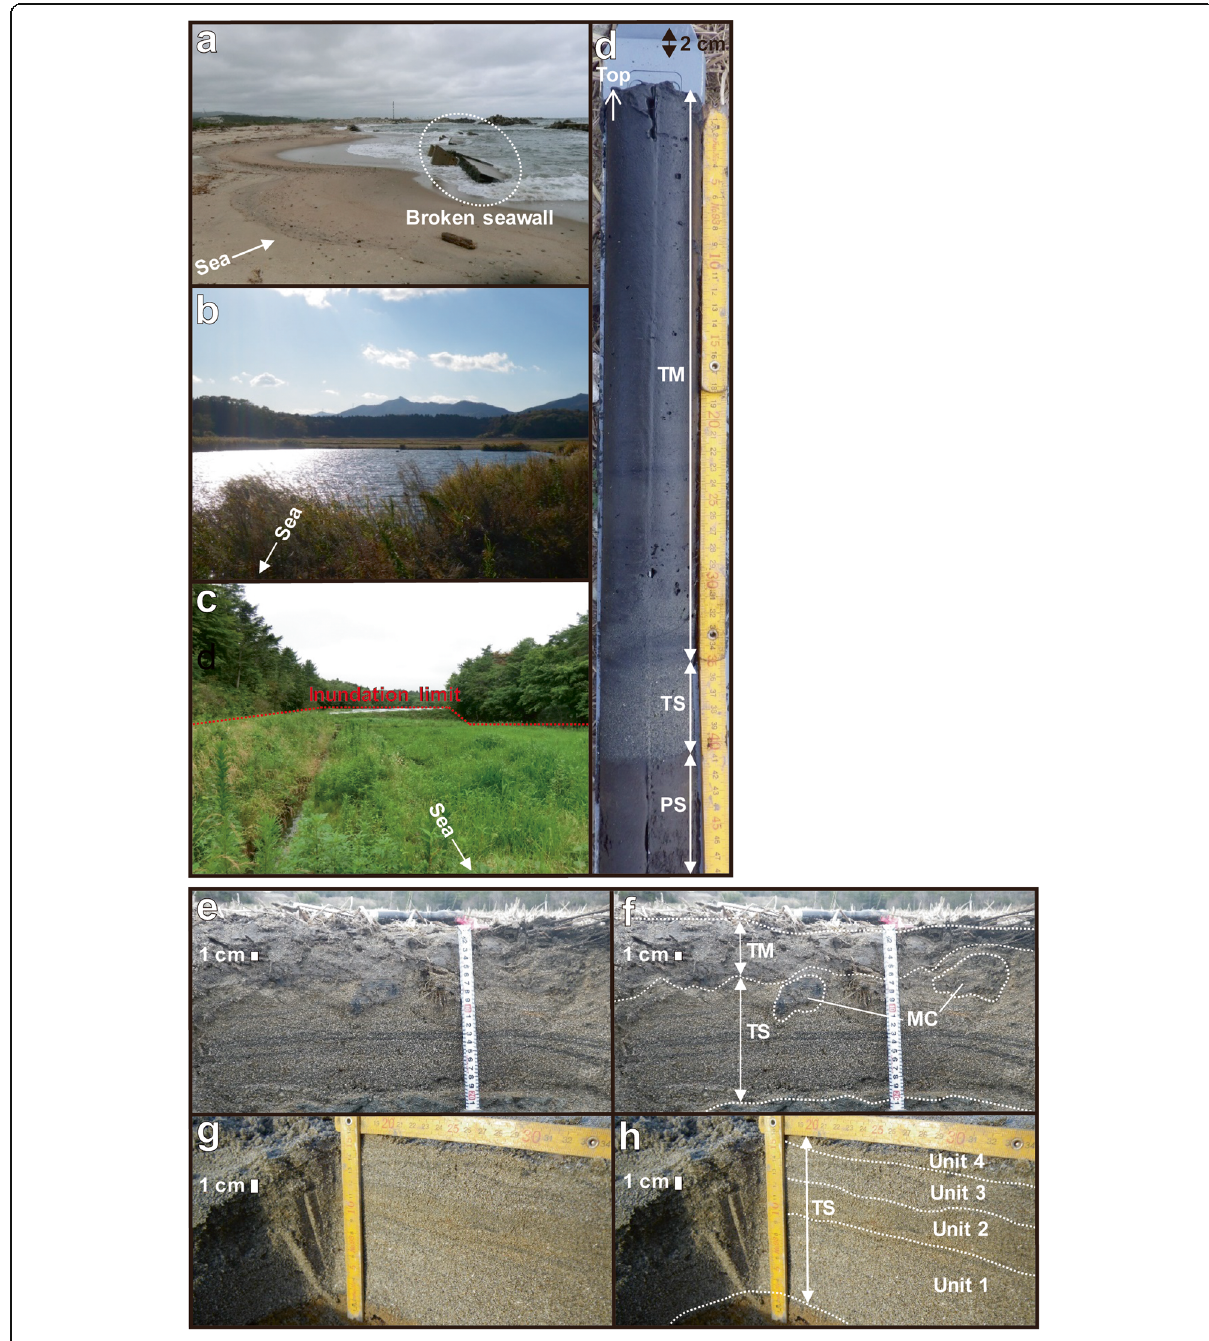
Fig. 2 Photographs taken in the study area. a Beach eroded and seawall broken by the 2011 tsunami (July 19, 2012). b Pond (Suijin-numa) (November 21, 2012). c Inundation limit at valley head in the upper main valley (July 18, 2012). d Tsunami sand layer covered with tsunami mud layer in the pond (April 11, 2013). Photograph sites are portrayed in Fig. 1b. TS, tsunami sand layer; TM, tsunami mud layer; PS, pond sediment. e , f Tsunami sand layer covered with tsunami mud layer (April 11, 2013). g , h Tsunami sand layer with four sub-units (April 11, 2013). e , g Raw photos. f , h Photos with interpretation of the structure of the tsunami deposit. Photograph sites are portrayed in Fig. 1b. TS, tsunami sand layer; TM, tsunami mud layer; MC, mud